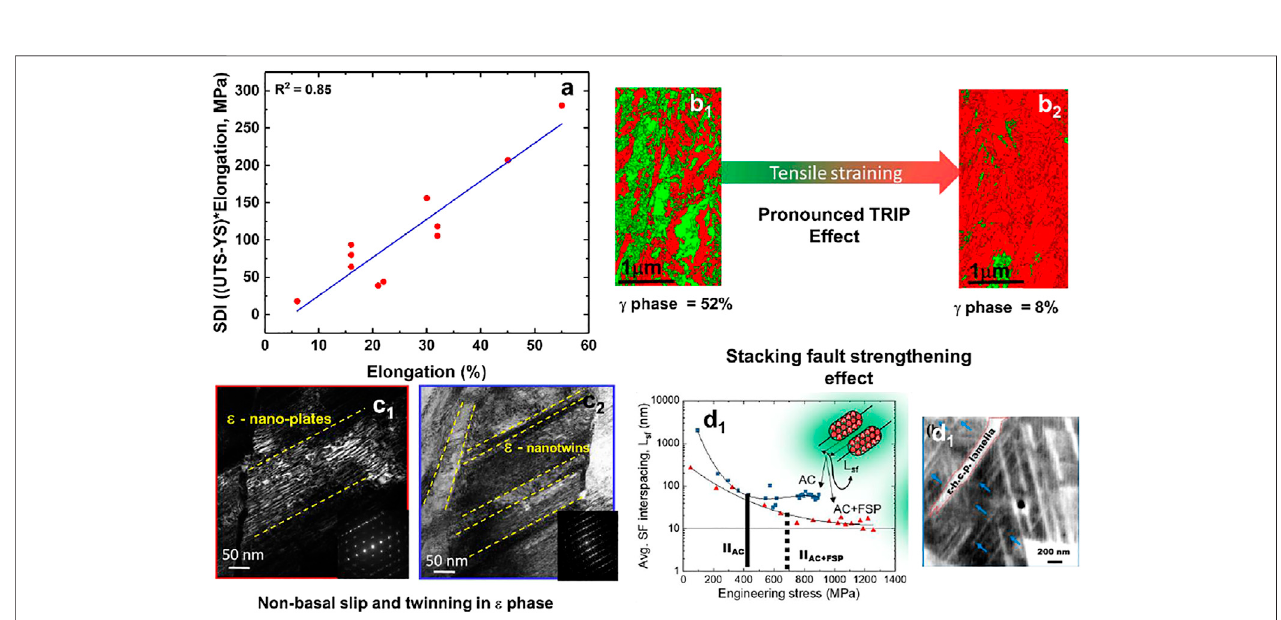
FIGURE3 | Unexpected stress-strain response in T-HEAs: (A) SDI vs total elongation plots for all T-HEAs processed with various processing routes. EBSD phase mapsforCu-HEA(b 1 )beforeand(b 2 )afterdeformationshowingtheTRIPeffect.Bright- fi eldTEMimagesshowingtheformationof(c 1 )nano-platesand(c 2 )nano-twinsin the ε phase. (d 1 ) Plot of avg. SF interspacing and engineering stress, and (d 2 ) high-resolution BSE image showing SFs and ε lamella in Cu-HEA (Nene et al., 2020; Frank et al., 2021; Nene et al.,